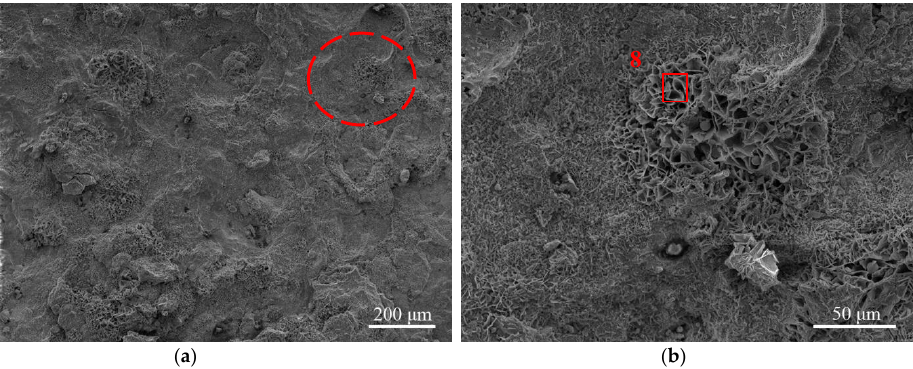
Figure 4. Surface microscopic morphologies of the rust layer and EDS analyses after 2 months of atmospheric exposure.